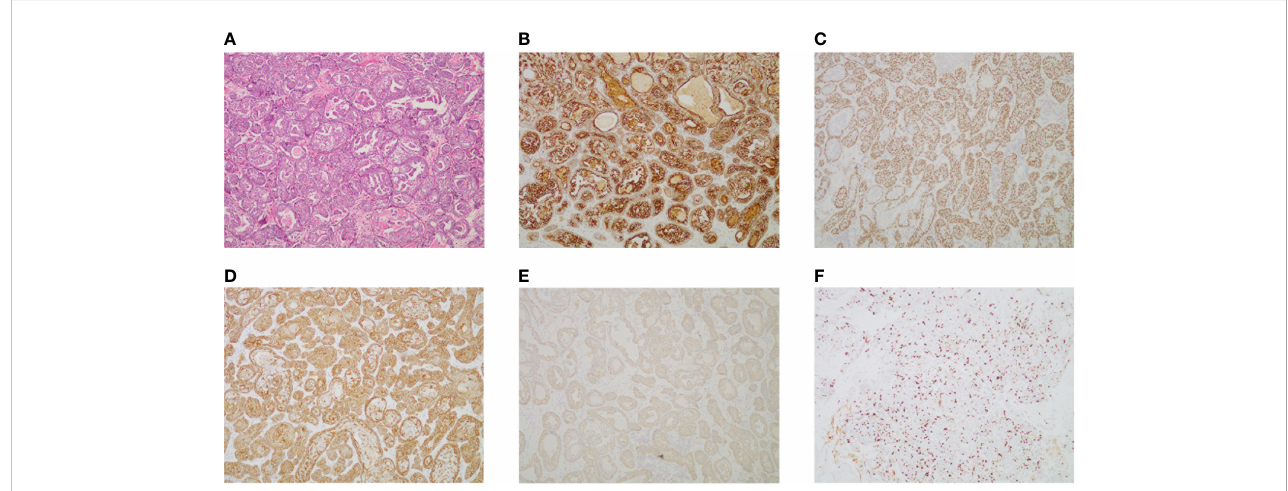
FIGURE 2 (A) Pathologic examination of tumor tissue con fi rmed typical SGC histological features (hematoxylin and eosin stain 100). (B) The tumor cells were positive for CK7 (CK7 stain 100). (C) The tumor cells were positive for P63 (P63 stain 100). (D) The tumor cells were positive for CK5/6 (CK5/6 stain 100). (E) The tumor cells were positive for partial CK14 (CK14 stain 100). (F) The expression of Ki-67 in tumor tissue (Ki-67 stain